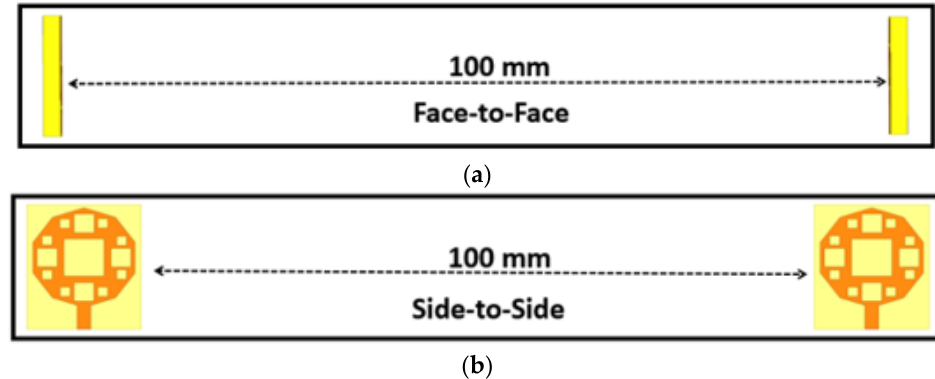
Figure 28. Analysis in time-domain with ( a ) frontal and ( b ) lateral orientations.